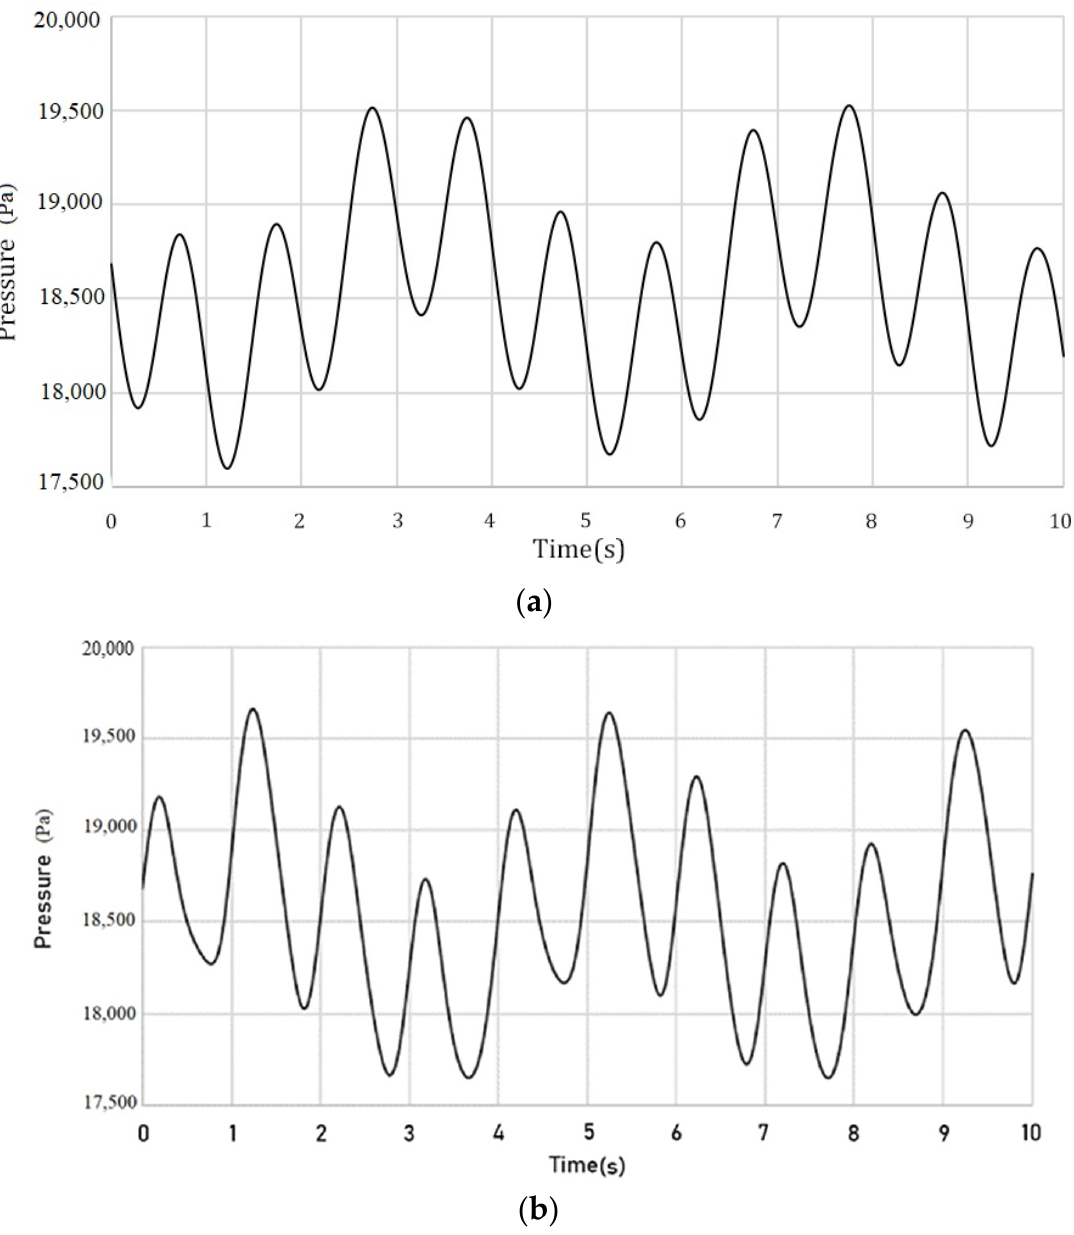
Figure 8. The hydrodynamic pressure in the tank with a baffle. ( a ) Hydrodynamic pressure acting on the baffle at point 4; ( b ) hydrodynamic pressure acting on the baffle at point 9.